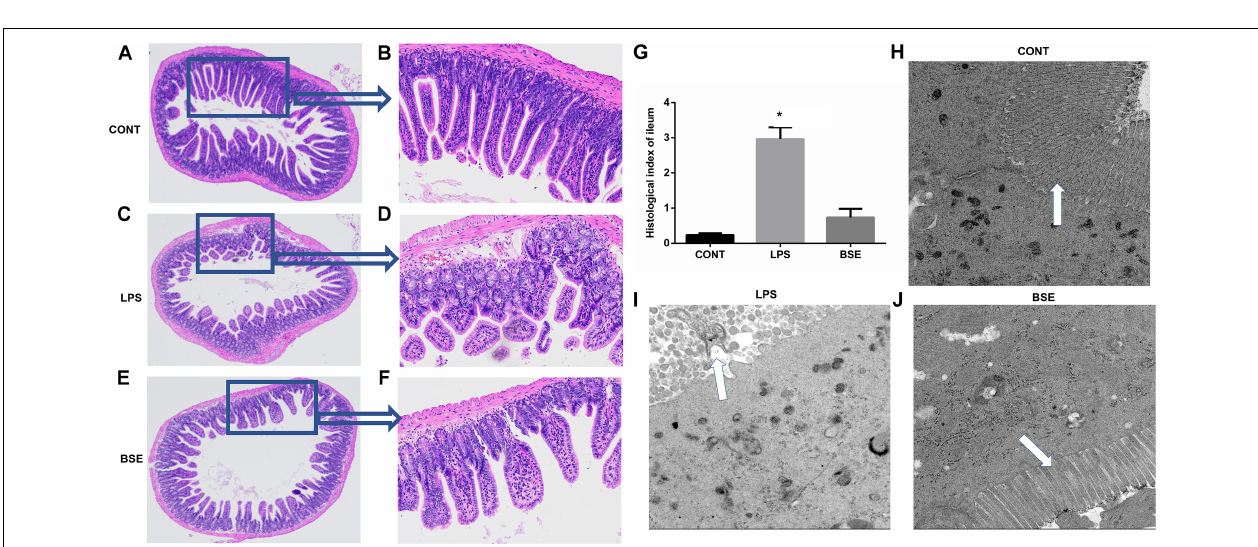
FIGURE 3 | Effects of Blidingia sp. extract on ileum morphology in lipopolysaccharide – challenged mice. (A–F) HE staining of ileum morphology ( A,C,E , 100 × ; B,D,F , 40 × ); (G) Histological index of ileum; (H–J) ultrastructural observation of microvilli in ileum (transmission electron microscopy, 5,000 × ). CONT, mice gavaged with sterile saline; LPS, mice injected with lipopolysaccharide; and BSE, mice gavaged with Blidingia sp. extract and injected with lipopolysaccharide. Values are expressed as mean ± SEM, n = 3; ∗ p <